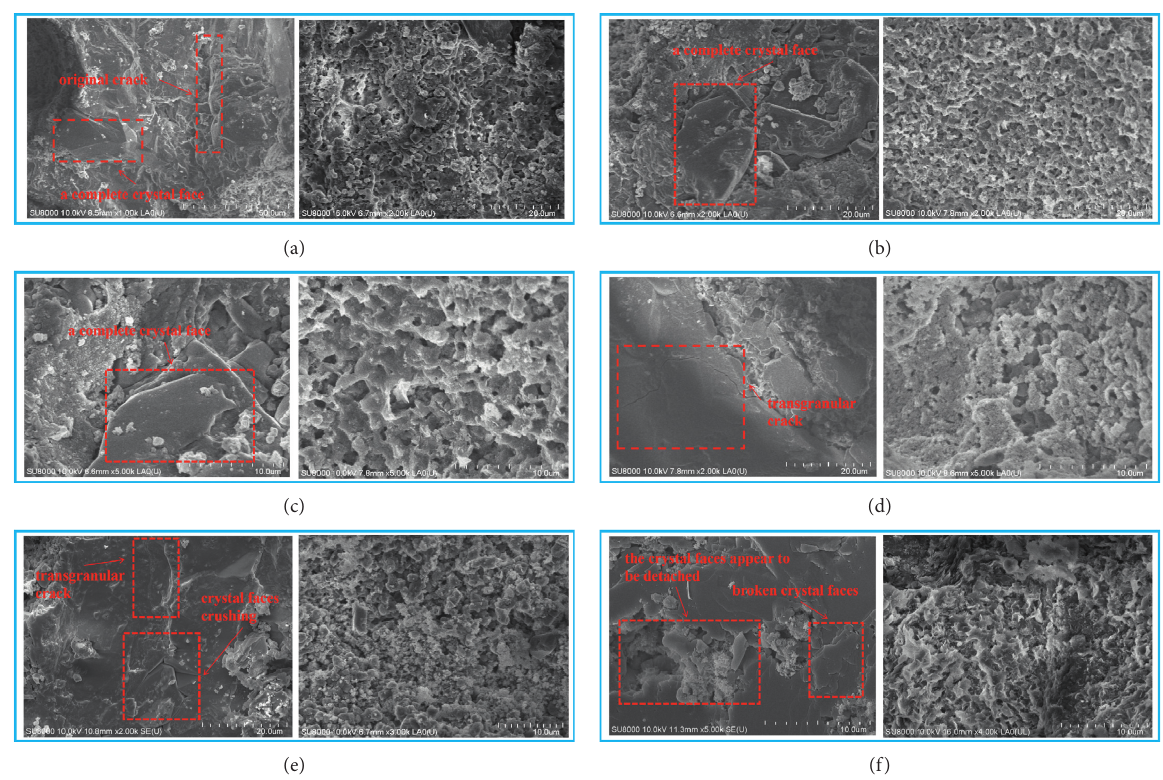
Figure 13: SEM images of rock fractures and pores in samples A-S-1 (a), B-S-2 (b), C-S-1 (c), D-S-3 (d), E-S-3 (e), and F-S-2 (f).